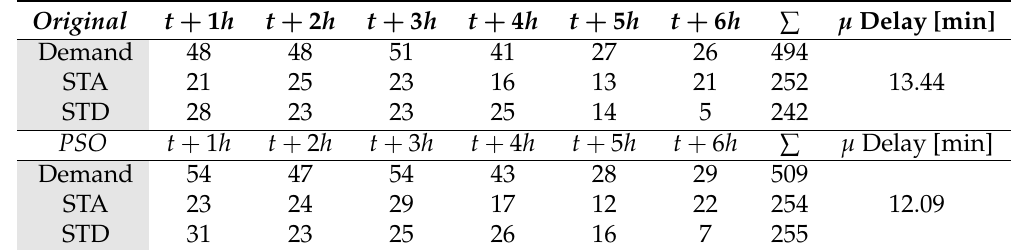
Table 5. PSO results of calculations at LGW under reallocation of STA and STD at full demand satisfaction for example day 5 January